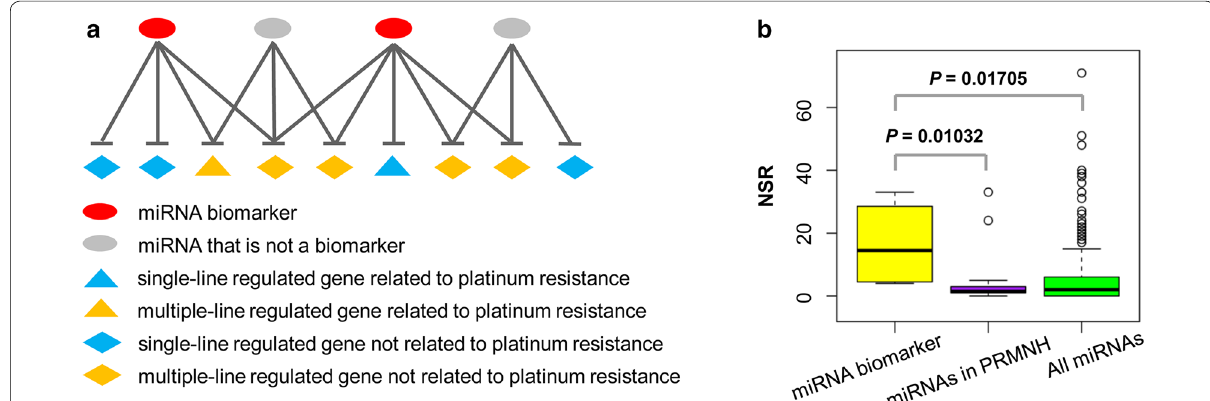
Fig. 2 Schematic description of criteria for identifying platinum resistance-associated miRNA biomarkers based on miRNA-mRNA regulatory relationships. a Schematic description of miRNA-mRNA regulatory types. b NSR distribution of the identified miRNA biomarkers, all miRNAs in